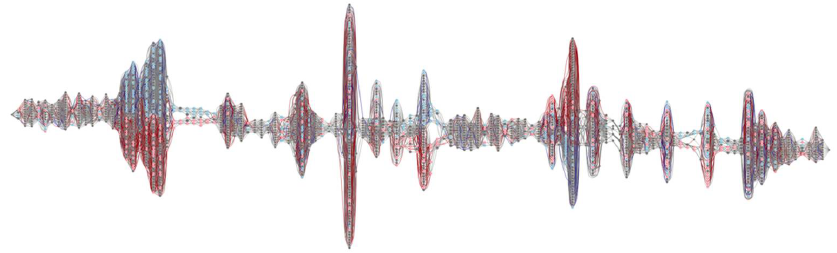
Figure 9. The integrated model from the collected manufacturing log. According to the number of activities included in the log, the integrated model had 120 vertical lines (i.e., 118 activities and artificial start and end), which included multiple states, i.e., manufacturing resources. For example, in the leftmost vertical line, four resources were engaged: one blue, one red, and two gray nodes. After that, we performed the rest of the proposed methodology, i.e., statistical analysis with all significance level thresholds as 0.05 and model simplification with simplifiedIM1 . Figure 10 presents the quality-based simplified resource model.